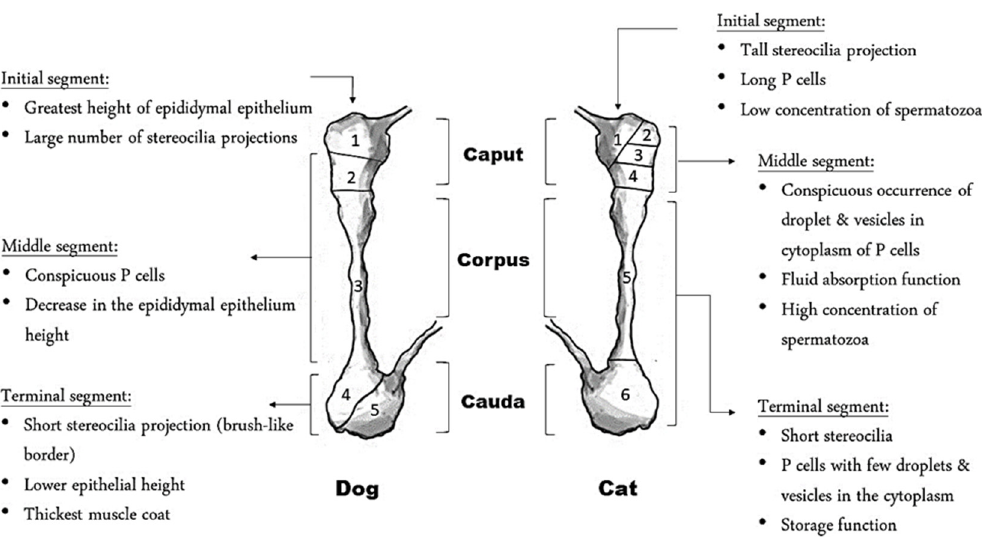
Figure 2. Histological difference between the epididymis of the dog and cat. P refers to principal cells.